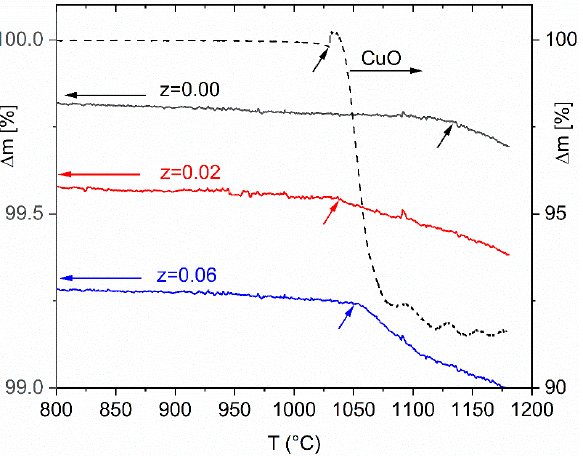
Figure 7. Relative mass losses (TG) for z = 0.00, z = 0.02, z = 0.06, and CuO vs. temperature.